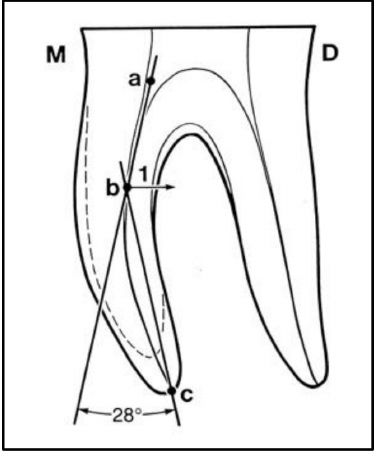
Figure 2. Schematic view of the root canal curvature measurement according to Schneider’s method. Point “a” was first identified on the file at the root canal orifice and a line was drawn from point “a” parallel to the file until the point of deviation (point “b”). Point “c” was then identified at the apical foramen, from which a line was drawn to point “b”. The angle formed between the two aforemen- tioned lines indicates the degree of root canal curvature. M: mesial; D: distal; 1: A perpendicular line from the point b to the line ac gives the curvature